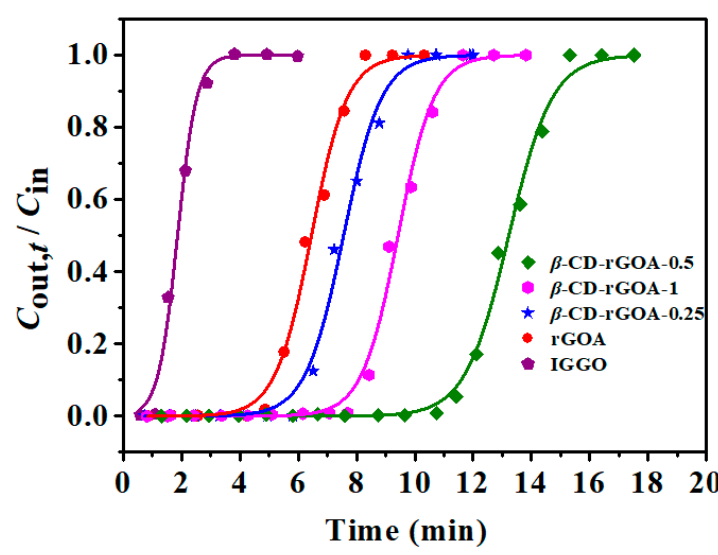
Figure 8. Breakthrough curves of different adsorbents for L2.